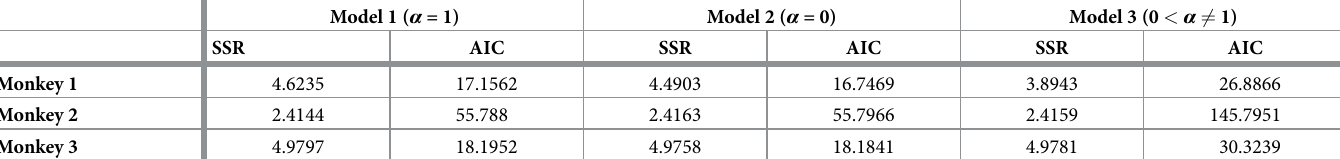
Table 1. SSR and AIC values for each of Model 1 ( α = 1), Model 2 ( α = 0), and Model 3 (0 < α 6¼ 1) fitted to each of the three monkeys.